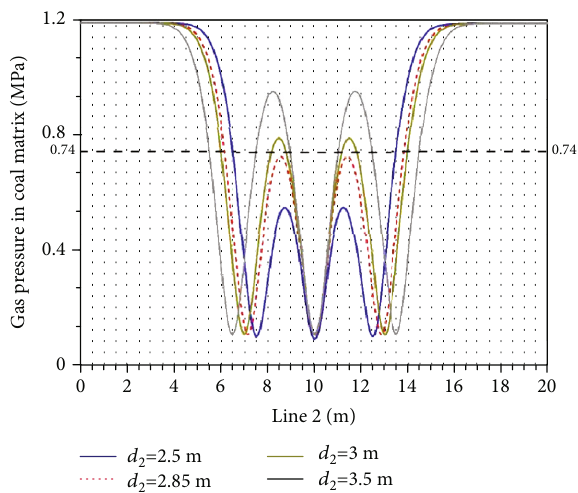
Figure 5: Distribution trend of gas pressure in coal matrix on monitoring line under di ff erent slot spacing d 2